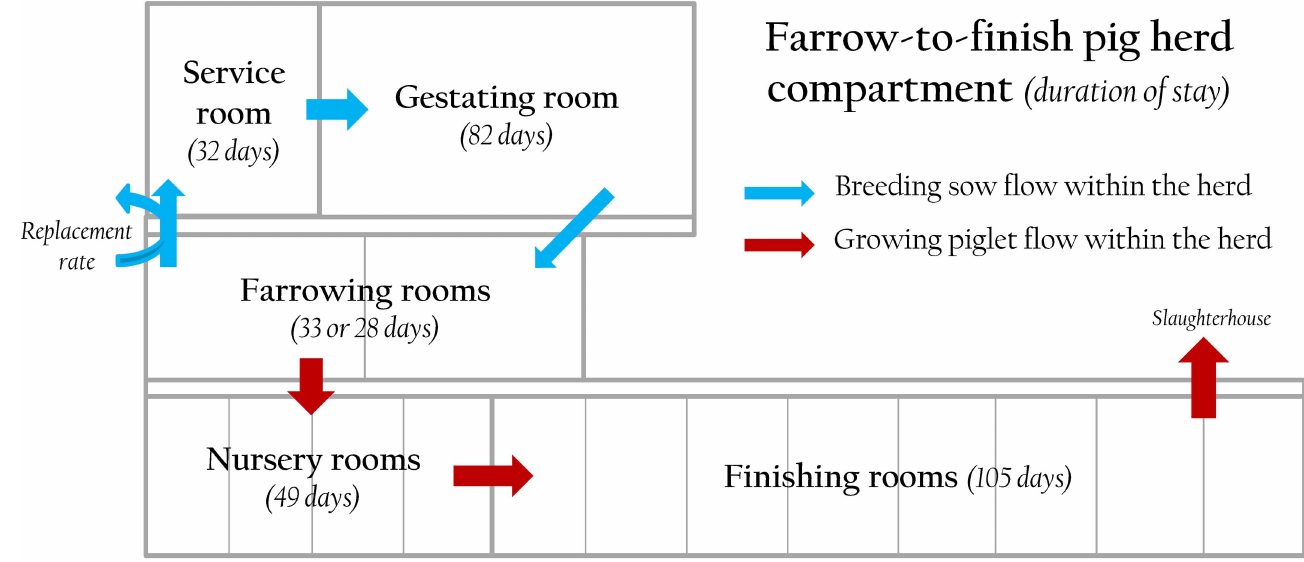
Fig 1. Facilities modelled in the farrow-to-finish pig herd.